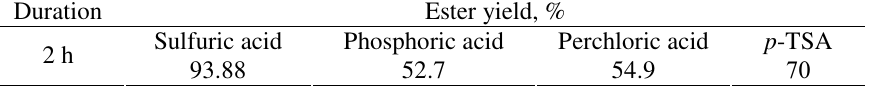
Table 1. Comparison of the esterification yields in reactions using various catalysts